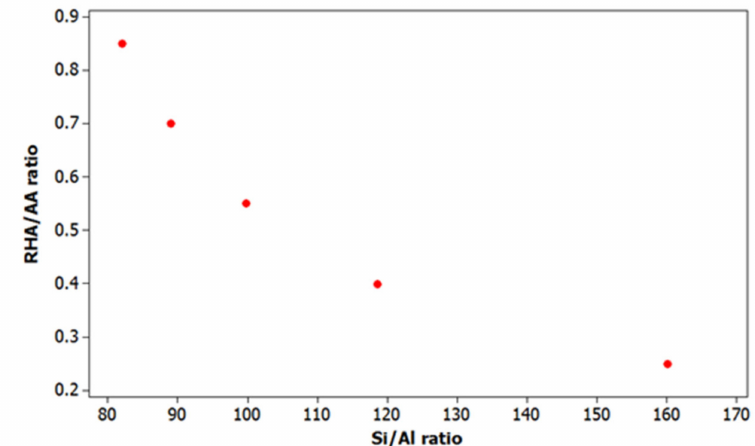
Figure 7. Relationship plot between RHA/AA ratio and Si/Al ratio.